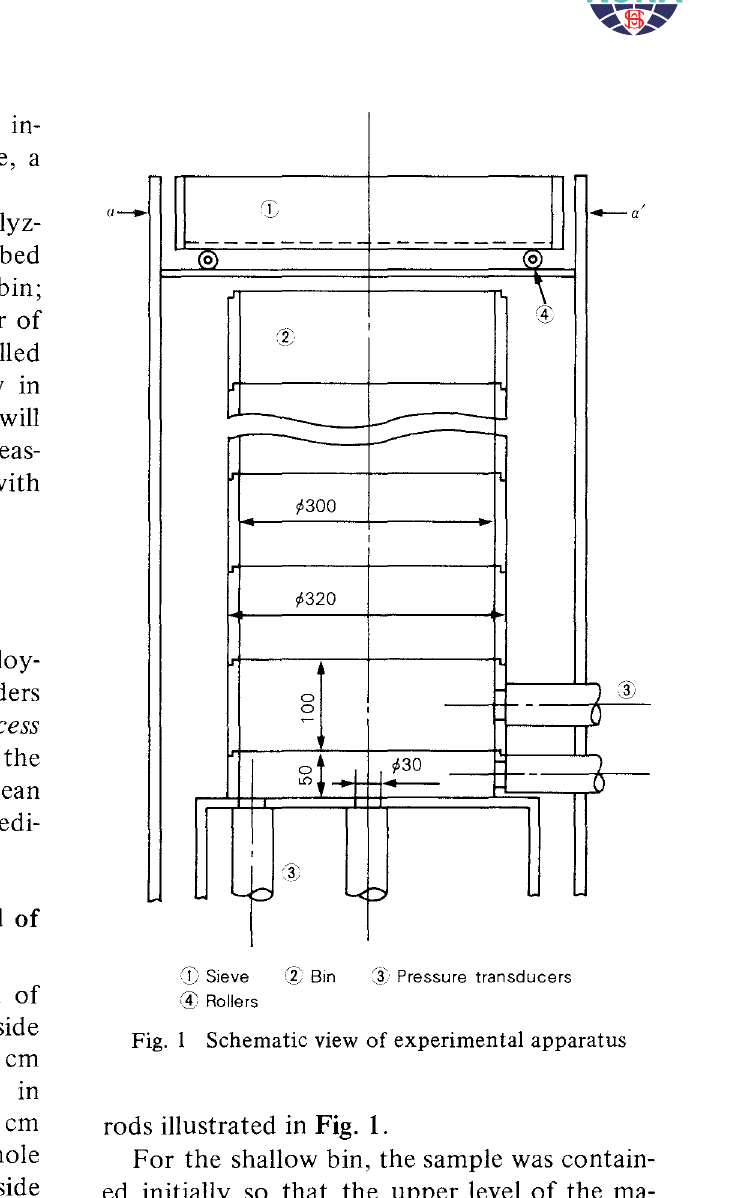
rods illustrated in Fig.